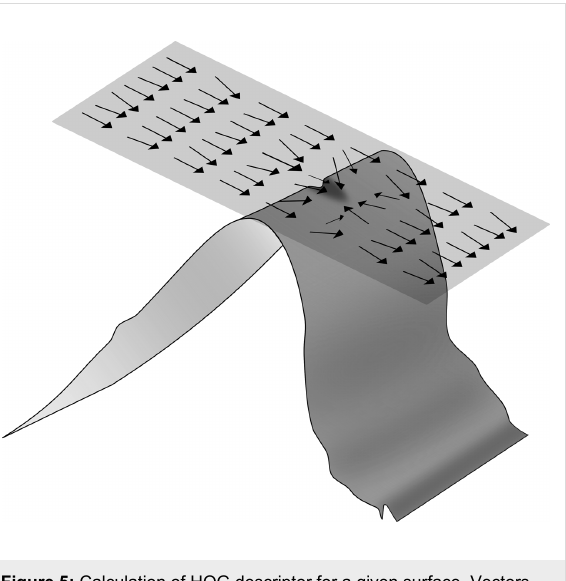
Figure 5: Calculation of HOG descriptor for a given surface. Vectors points to the direction of highest gradient; this should be a parallel set of vectors if the sample was perfect. Deviations from this direction show the presence of defects. See text for details.